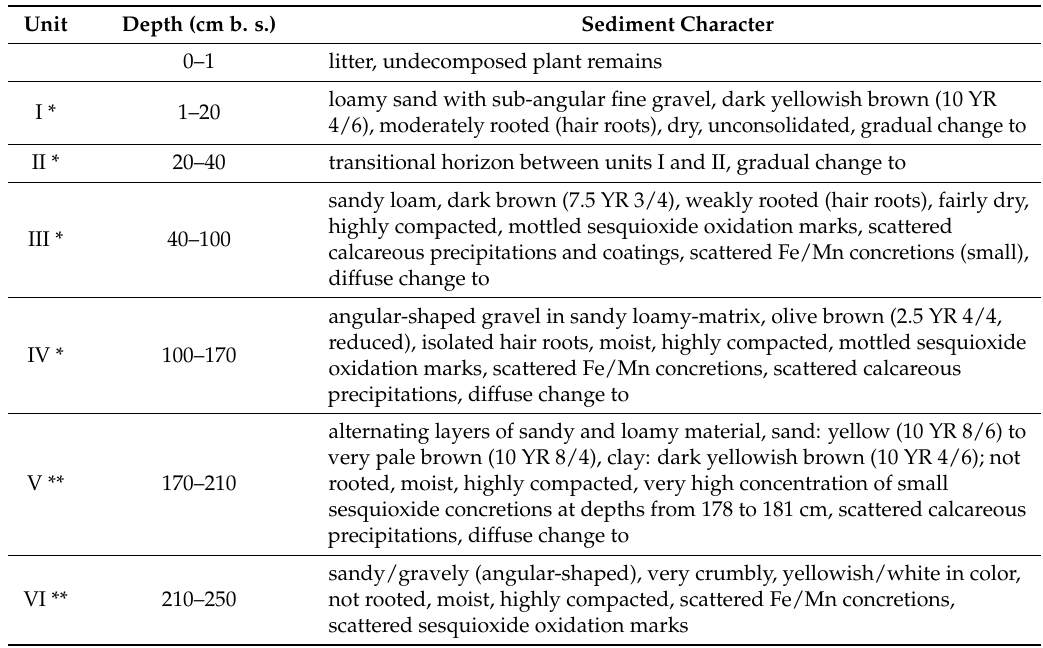
Table 3. Sediment characteristics drilling NA01.